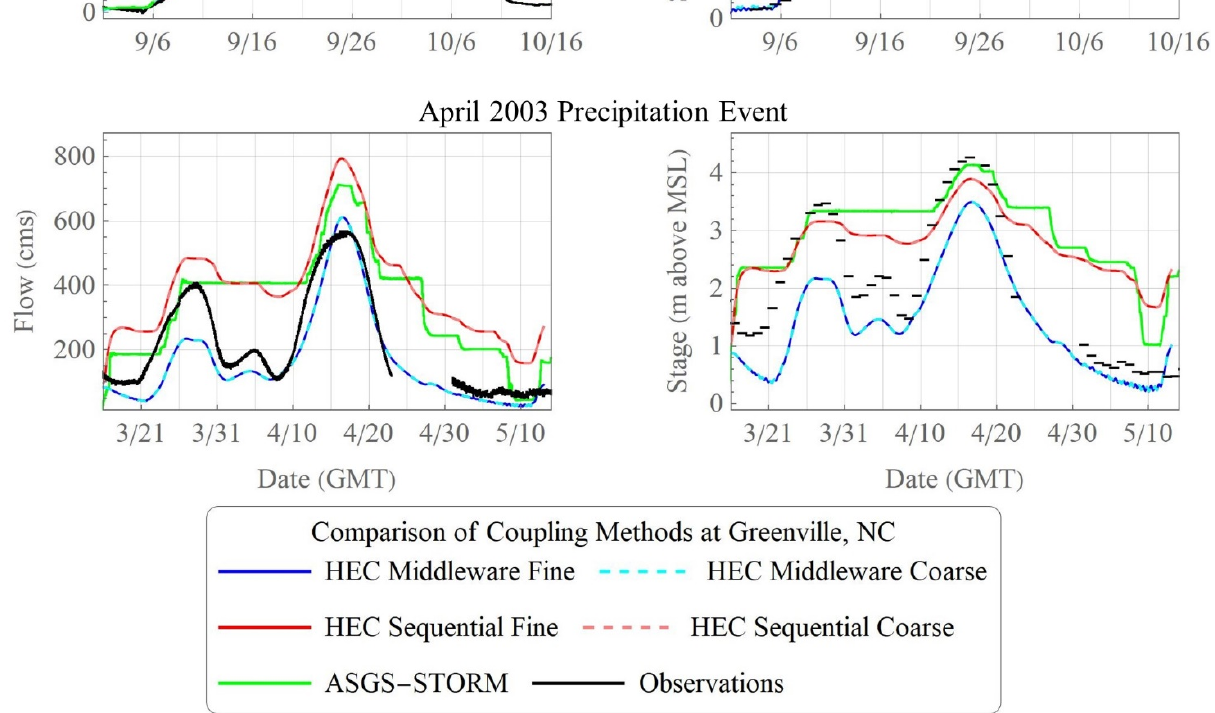
Figure 7. Comparison of modeled and observed flow and stage for the Tar River at Greenville, NC.